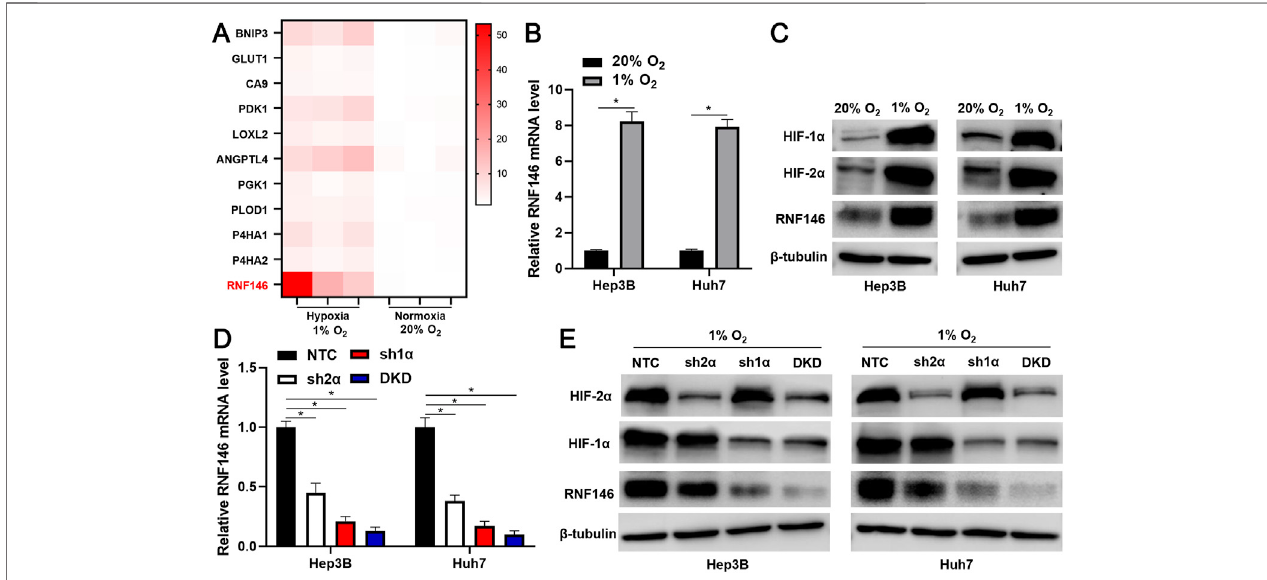
FIGURE1| RNF146isa hypoxia-responsivegene. (A) Heatmap oftenknown hypoxiatarget genes and RNF146 expression inHep3B cells under normoxia (20% O 2 )andhypoxia(1%O 2 )conditions. (B) TheexpressionofRNF146mRNAinHCCcellsundernormoxiaandhypoxiaconditionswasmeasuredbyRT-qPCR. (C) HIF-1 α , HIF-2 α and RNF146 protein levels were determined by WB in HCC cells under normoxia and hypoxia conditions. (D) The lentivirus-mediated shRNAs against HIF-2 α (sh2 α ), HIF-1 α (sh1 α ), HIF-1 α /2 α (DKD) and non-targeting shRNA (NTC) were transduced into HCC cells. After incubation under hypoxia conditions, RNF146 mRNA level in HCC cells was measured by RT-qPCR. (E) HIF-1 α , HIF-2 α and RNF146 protein levels were determined by WB in transfected HCC cells under hypoxia conditions. * p <